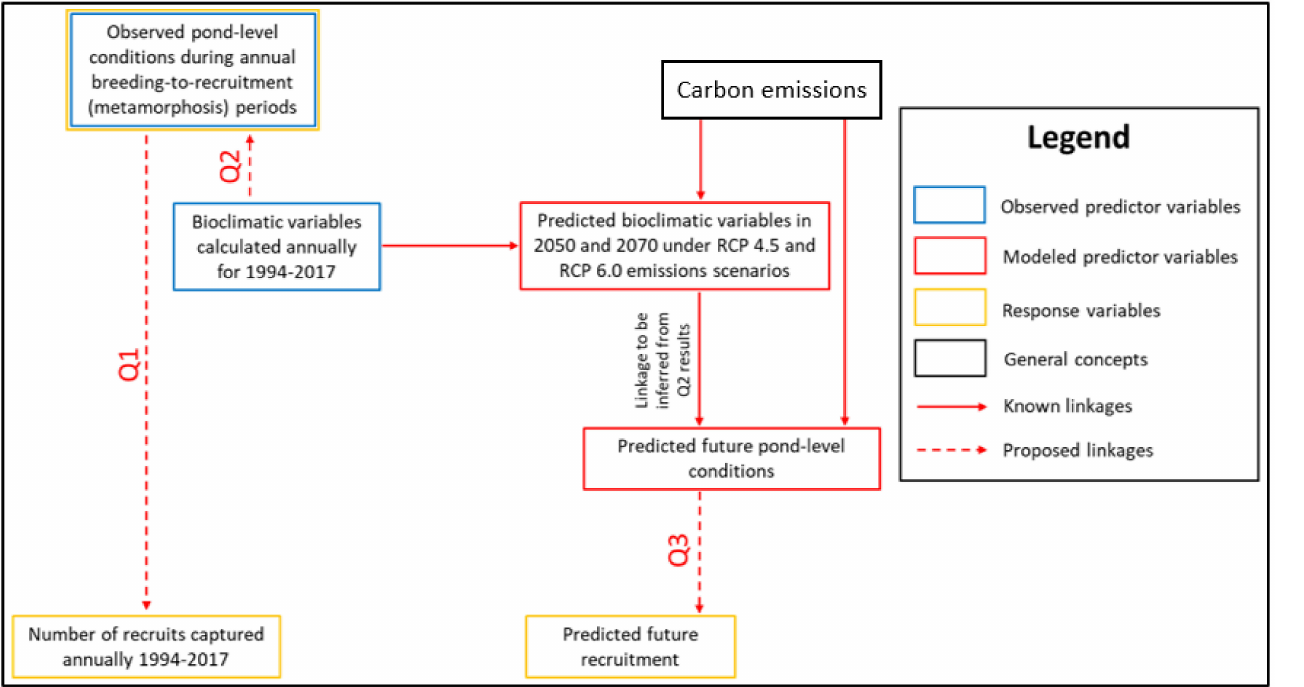
Figure 1. Diagram of the analytical framework for this study, Ocala National Forest, Marion County, Florida. Our analyses consisted of (1) predicting annual hylid recruitment from measured envi- ronmental variables during breeding-to-metamorphosis periods, (2) predicting values of the above variables using Bioclim variables [25], and (3) predicting environmental conditions important for recruitment in 2050 and 2070 under RCP 4.5 and RCP 6.0 carbon emissions climate scenarios, then using those predictions to predict future hylid recruitment under